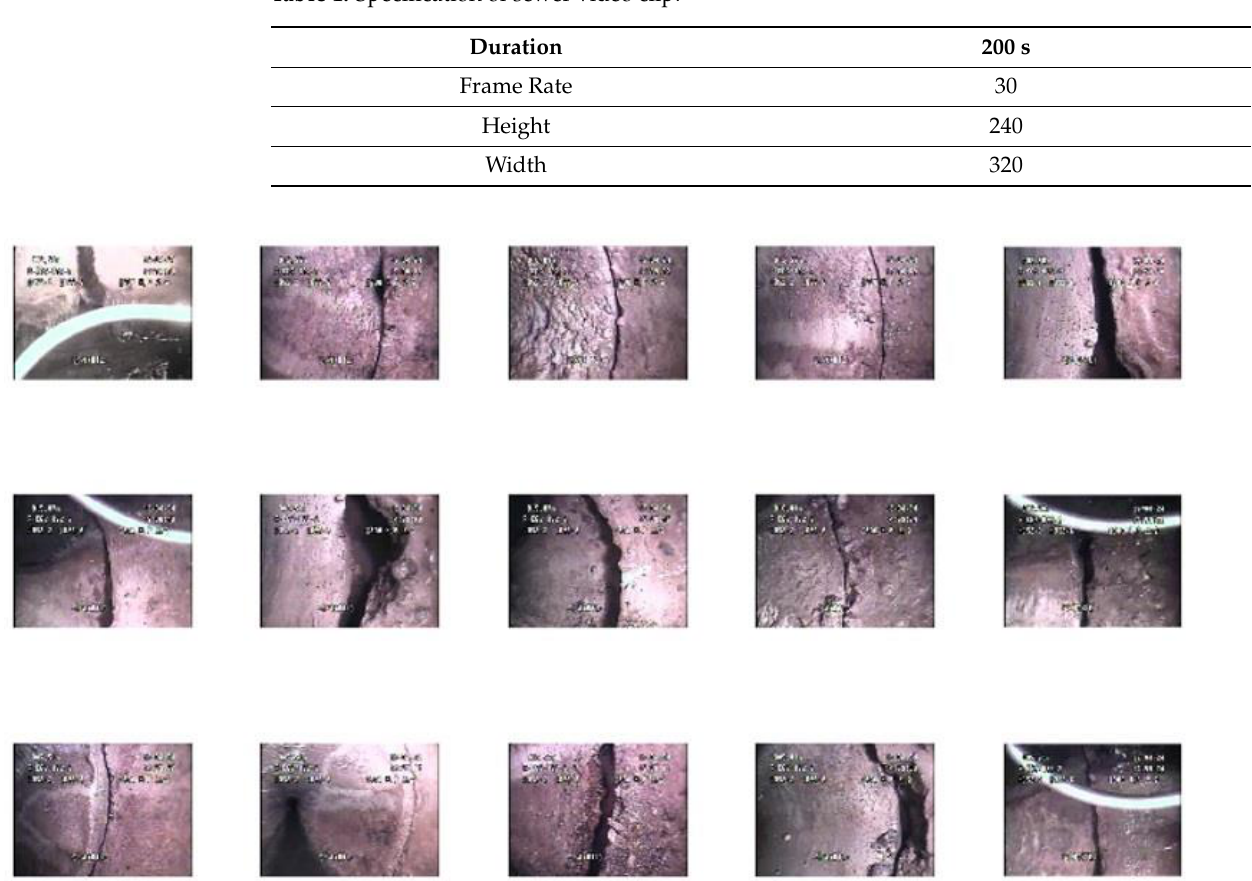
Figure 1. Sample images of cracks.